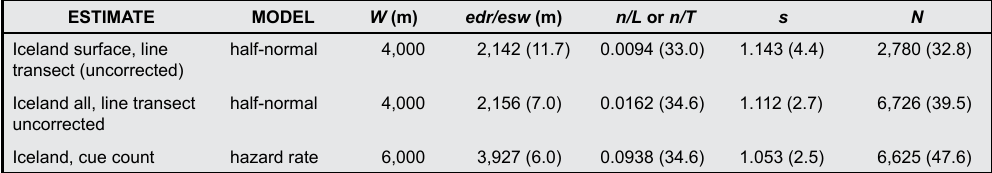
Table 1. Estimates of sperm whale abundance from NASS-2001 Icelandic shipboard surveys. First estimate is a line transect estimate based on animals at surface abeam only and needs to be corrected for availability by dividing by the proportion of the time spent at the surface. Second estimate is line transect based on all sightings and can not be corrected for availability. Third estimate is cue count estimate (fluke ups) with an assumed cue rate of 2 per hour. Coefficients of variation (%) are in parentheses. W - truncation distance; edr - effective detection radius, for cue count; esw - effective search width, for line transects; n/L - encounter rate, whales per nm, for line transects; n/T - encounter rate, whales per hour, for cue count; s - mean pod size; N - abundance estimate for the survey